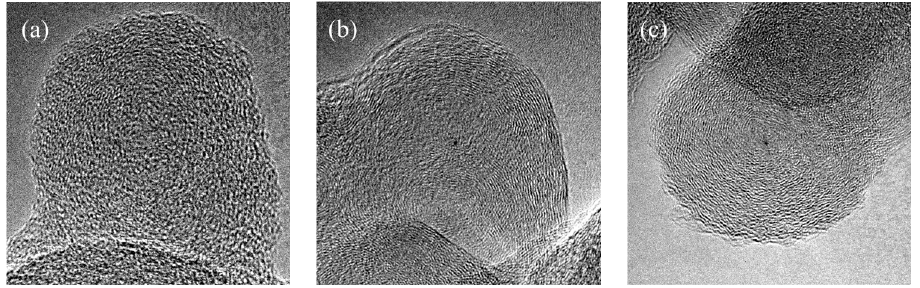
Figure 3. Field-emission transmission electron microscopy (FETEM) micrographs of ( a ) BDS, ( b ) NA-BDS, and ( c ) NA-BDS-OLA.